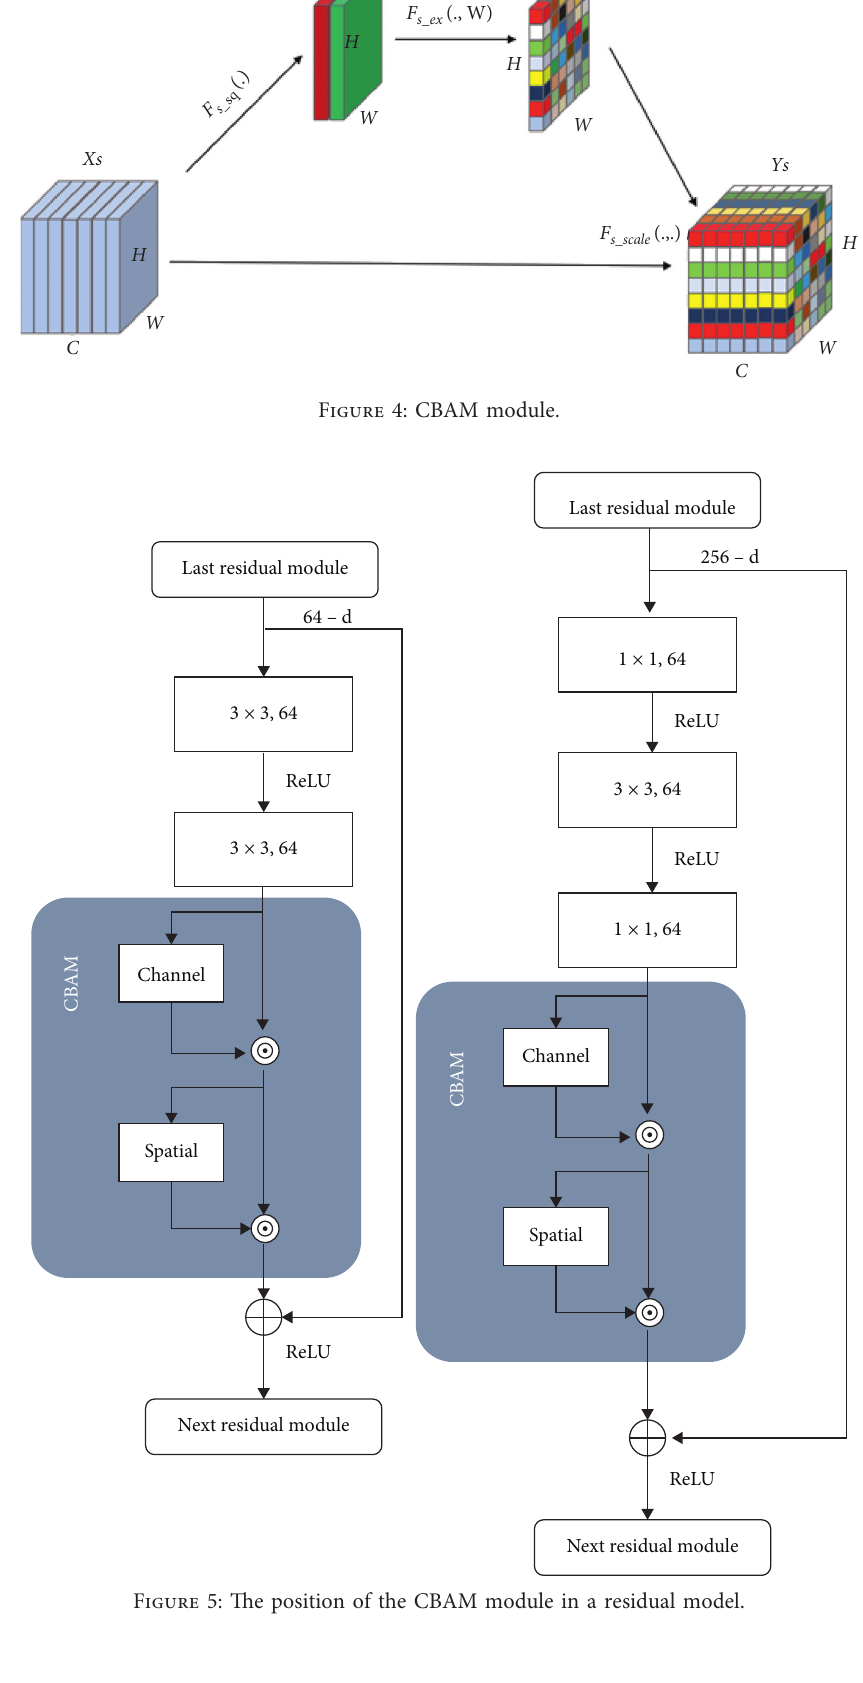
Figure 5: The position of the CBAM module in a residual